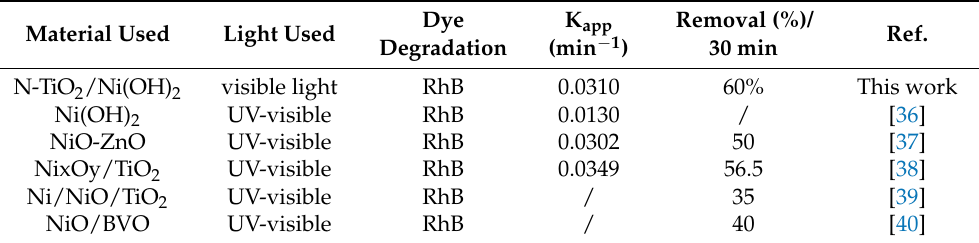
Figure 5. ( a ) Photodegradation of RhB for TiO 2 , N-TiO 2 , Ni(OH) 2 , and N-TiO 2 /Ni(OH) 2 of different Ni(OH) 2 contents under the irradiation of visible-light (>420 nm); ( b ) Natural logarithm degradation curves of different samples; ( c ) Rate constants (kR) of different samples for photodegradation of RhB; ( d ) five consecutive photodegeration curves of RhB over N-TiO 2 /1.0-wt% Ni(OH) 2 under the visible light irradiation. Table 1. Comparison of the catalytic performance of N-TiO 2 /Ni(OH) 2 with the previously reported data for the reduction in organic dyes of Rh